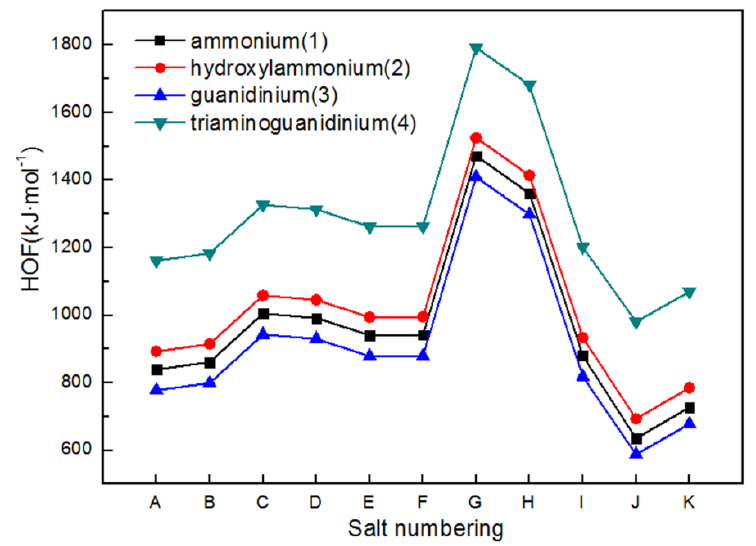
Figure 3. Comparison of the heats of formation (HOFs) of ammonium-based 4,8-dihydrodifurazano[3,4- b , e ]pyrazine-based salts.